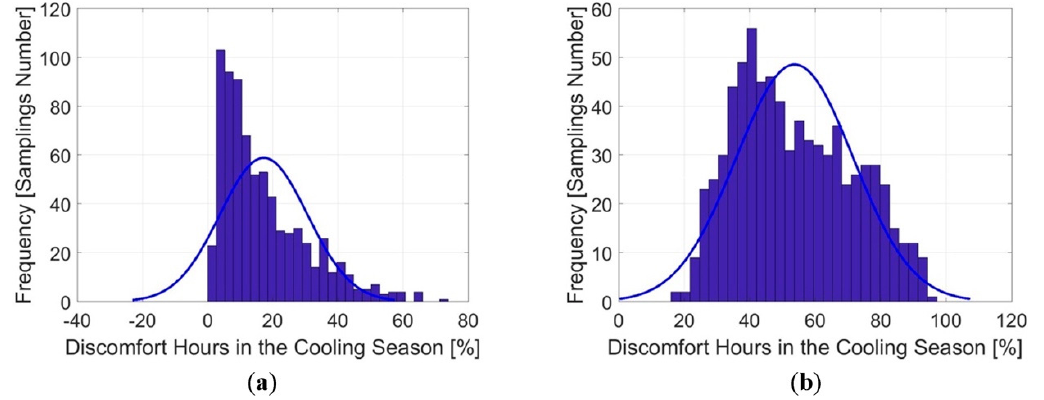
Figure 6. Distribution of DH c values in the building category. Summer period (June–August): ( a ) under typical climatic conditions; ( b ) for the 2050 climate scenario.